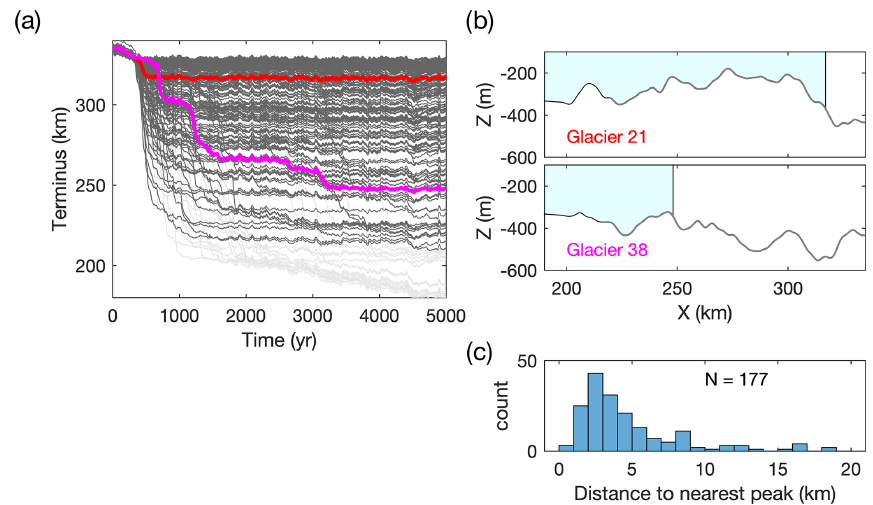
Figure 6. Simulating a population of glaciers with randomly generated bed topographies. (a) Transient spinup to find quasi-stable initial conditions in random topographies. Two glaciers are highlighted (red and magenta) to illustrate the range of different retreat histories. Light- grey lines indicate glaciers excluded from subsequent analyses. (b) Topographic profiles and terminus position at the end of the spinup for the two glaciers highlighted in (a) . Note the very different topography inland of the terminus. Glacier ice is colored blue. (c) Distribution of 177 terminus positions at t = 5000 years with respect to the nearest bed peak.